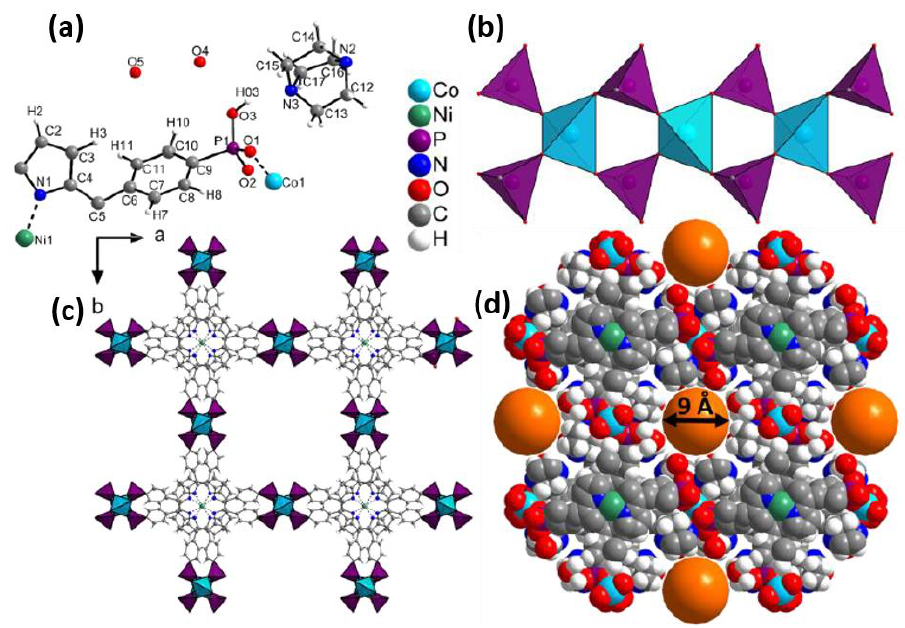
Figure 6. Structure of Co-CAU-36. ( a ) The details of the structure showing possible H bonds between the DABCO molecule and the phosphonate group on the porphyrin. ( b ) The 1D CoO 4 -PO 4 tetrahedral chain along the c-axis. ( c ) The structure of Co-CAU-36 viewed along the c-axis. ( d ) The ball filling model of the structure with the guest molecules shows the pore diameter of 9 Å. Reproduced from ref. [86] with permission from the John Wiley & Sons, Inc., copyright 2018. A zeolitic imidazolate framework ZIF-CO 3 -1 was another example whose structure was ab initio determined using high-resolution cRED data (1.0 Å ) [96]. ZIF-CO 3 -1 was built